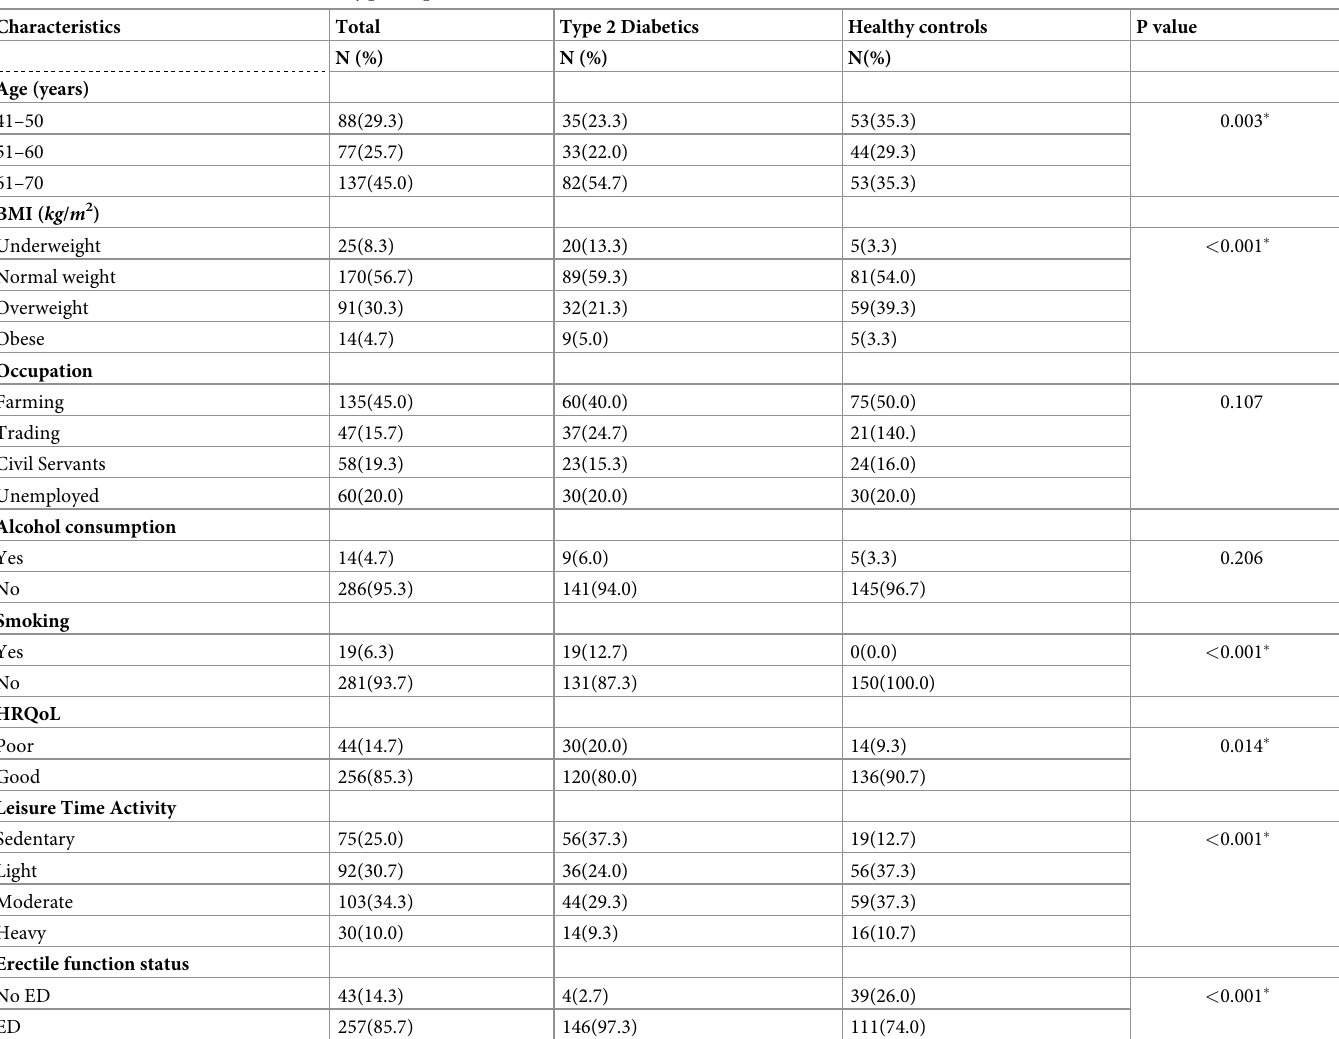
Table 1. Baseline characteristics of the study